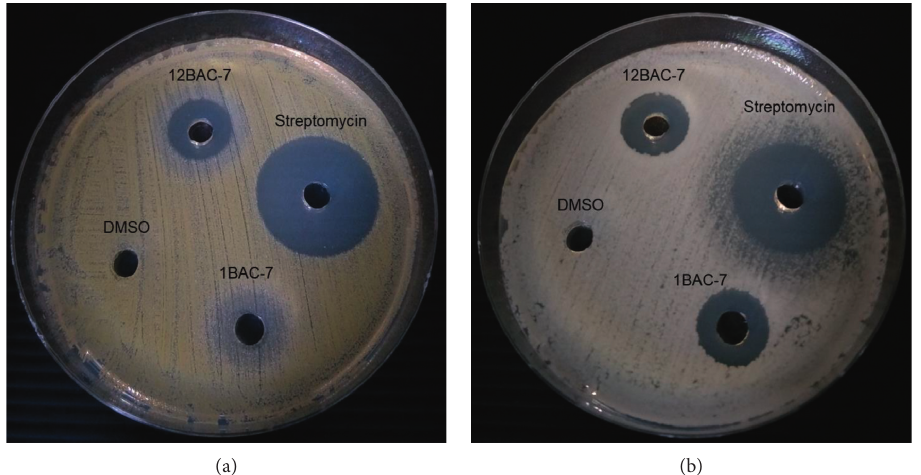
Figure 2: Inhibitory effect of 1BAC-7FE and 12BAC-7FE against S. aureus ATCC25923 (a) and B. cereus MTCC430 (b) determined using the agar well diffusion method with the positive (1mg/ml streptomycin) and negative control (10% DMSO).